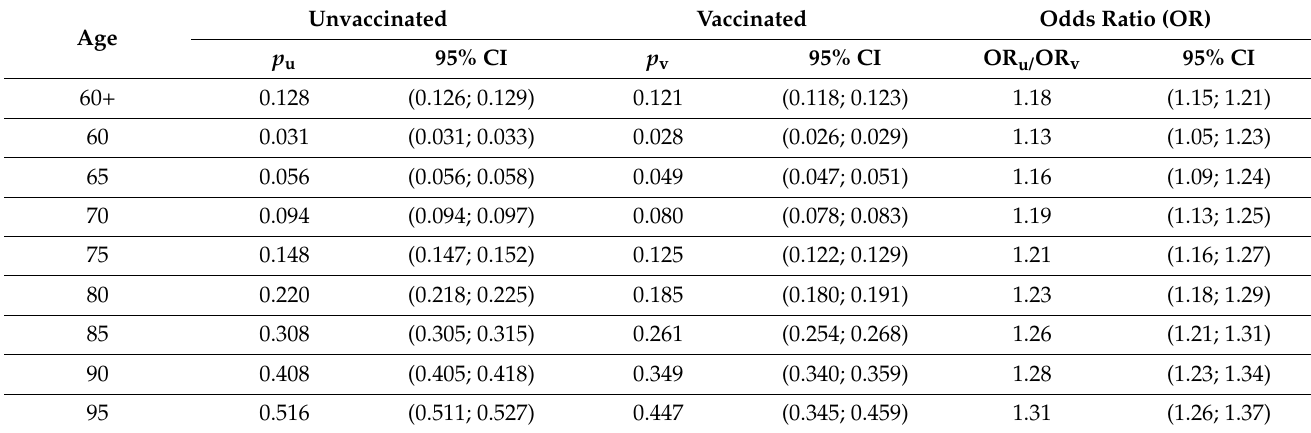
Table 2. The mean probability ( p ) of death related to COVID-19 infection among vaccinated and unvaccinated individuals by age group and the odds ratio (OR u /OR v ) between the